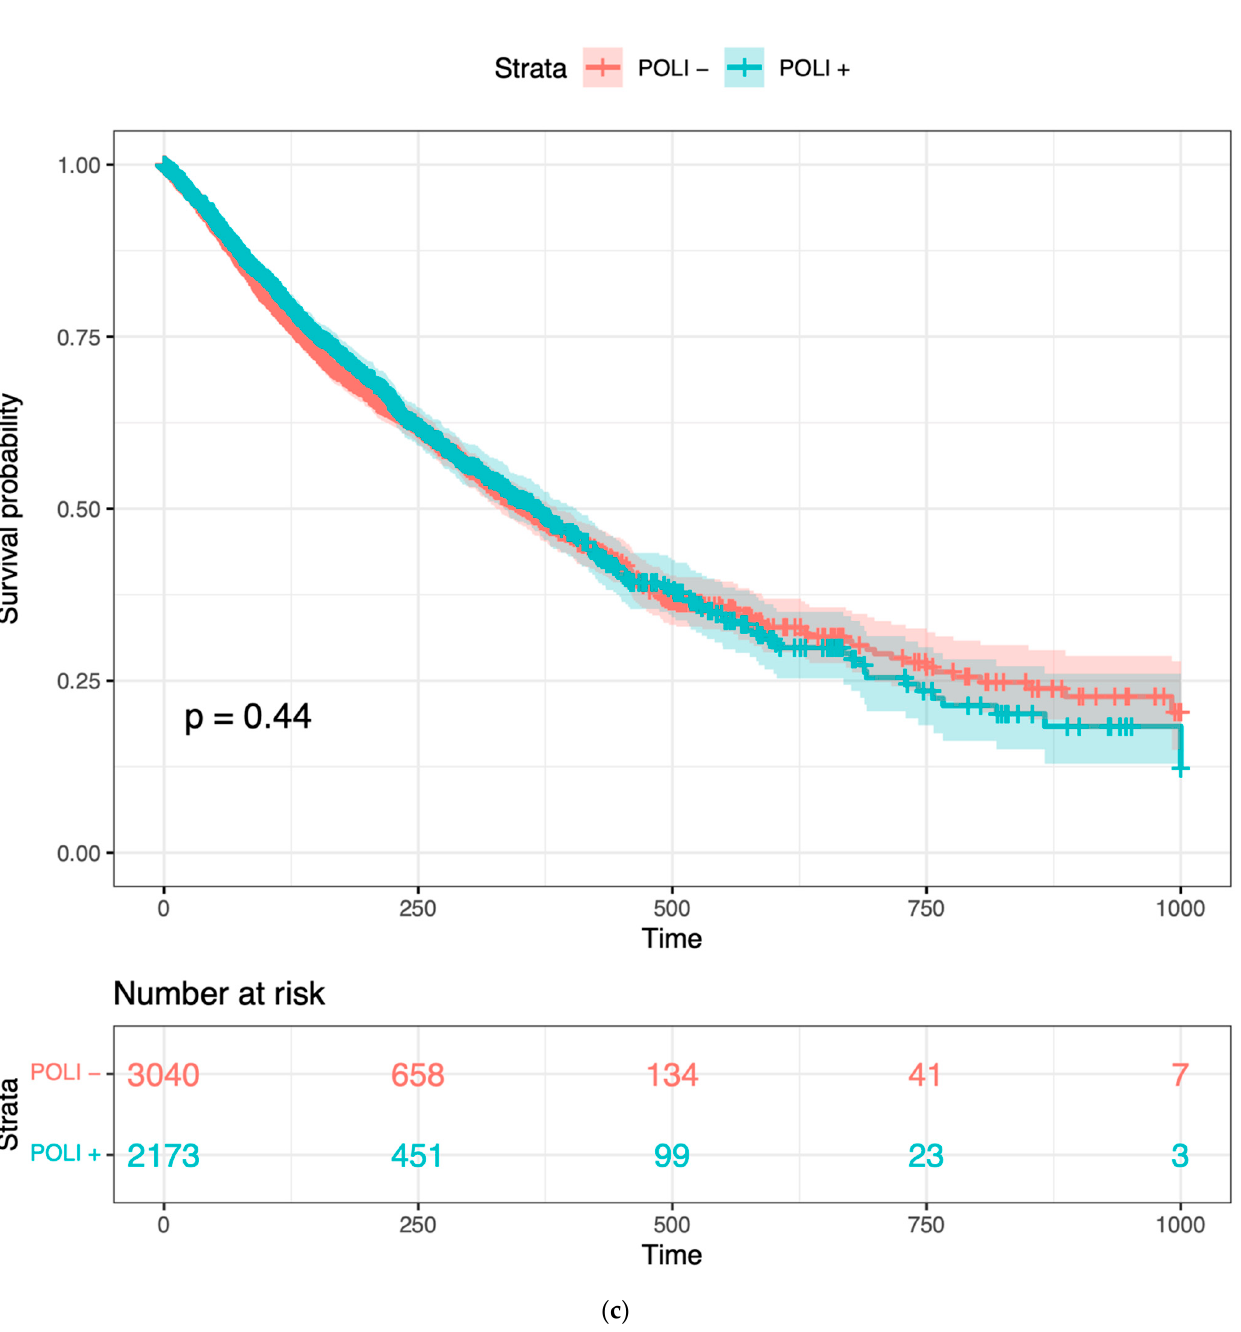
Figure 1. Prognostic value of POLI in CESC, PADD, and combined cancers: ( a ) Survival analysis of 291 patients in CESC vs. POLI expression; ( b ) Survival analysis of 176 patients in PAAD vs. POLI expression; ( c ) Survival analysis of 5213 patients in 11 cancer types.